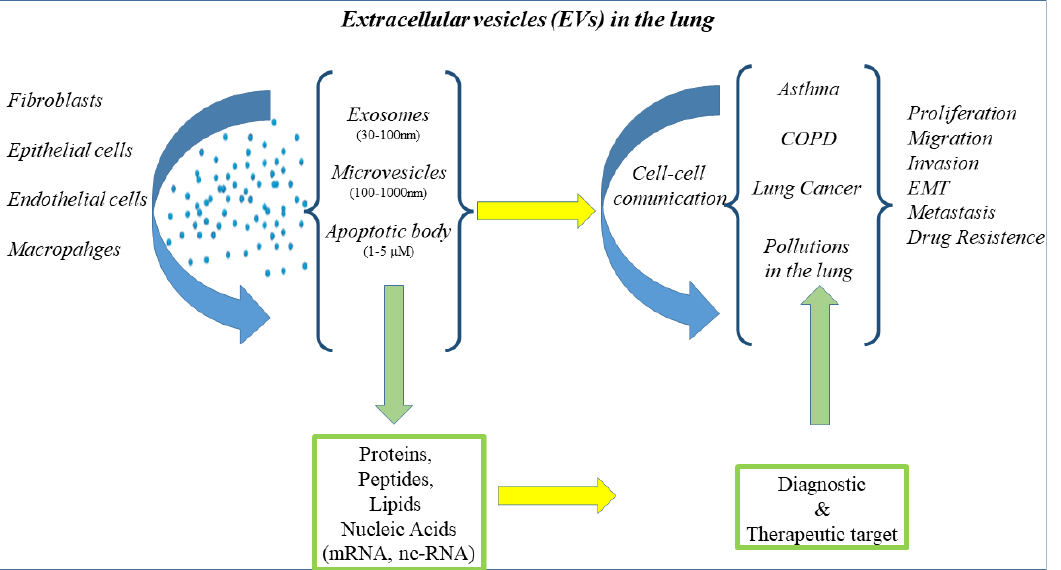
Figure 4. Cells of the lung release EVs of different size containing proteins, lipids, and nucleic acid involved in the mechanisms of cell–cell communication underlies the immunological response of respiratory disease such as asthma, COPD, LC, and airway diseases related to pollutions. EVs content show promise as diagnostic biomarkers and therapeutic targets in several lung diseases. BALF- and lung-tissue-derived EVs of healthy non-smokers, smokers have a miRNA profile with three differently expressed miRNAs in BALF, and one in the lung-derived EVs from COPD patients as compared to healthy non-smokers. MiR-122-5p is three- or five-fold downregulated among the lung-tissue-derived EVs of COPD patients as compared to healthy non-smokers and smokers, respectively. These data strongly suggest that miRNAs in the lungs of subjects with chronic lung diseases might be considered as potential biomarkers useful for therapeutic targets [121].